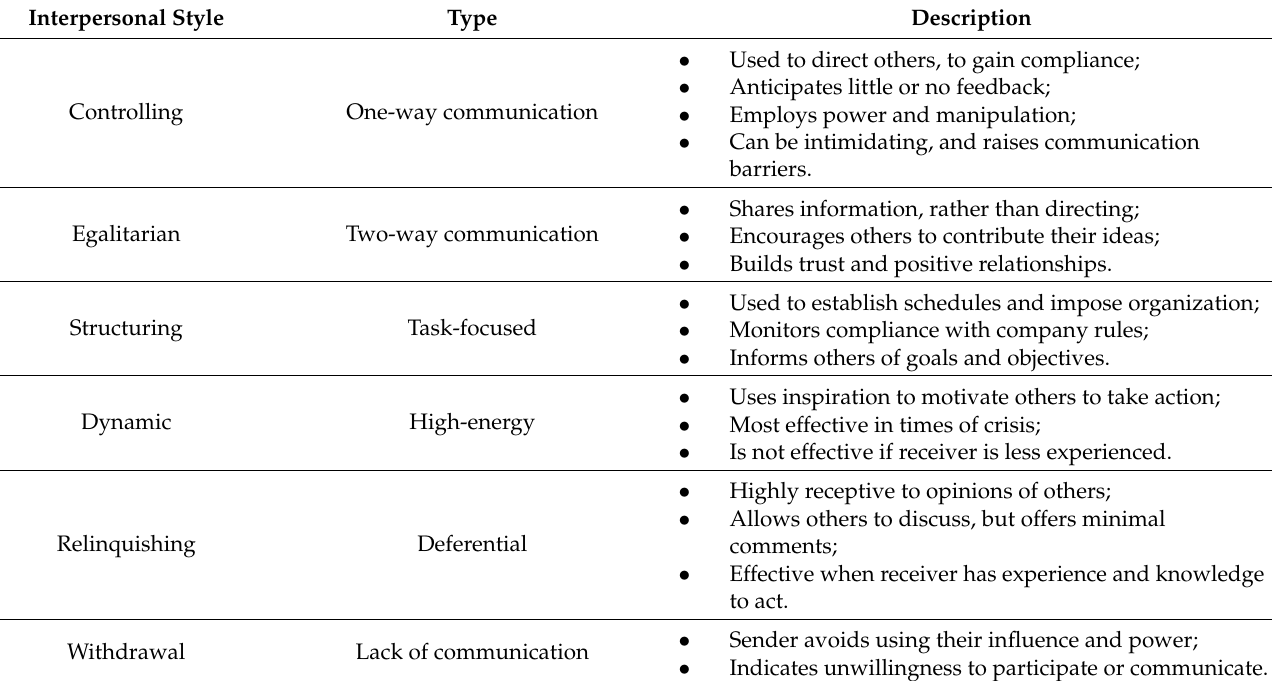
Table 1. Description of interpersonal communication styles (adapted from